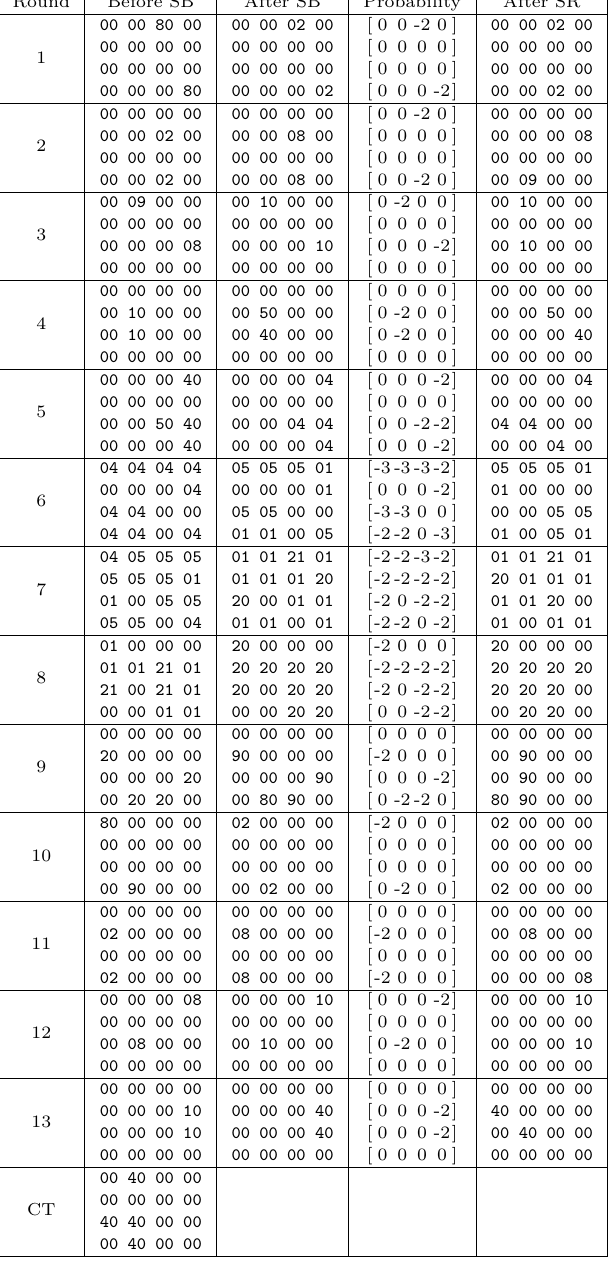
Table 11: 13-round differential characteristic for SKINNY-128 with probability 2 − 123 . Differences are represented by hexadecimal numbers. “Probability” shows logarithm of the probability of the S-box differential transition in the corresponding byte. The characteristic consists of 51 S-boxes with probability 2 − 2 and 7 S-boxes with probability 2 − 3